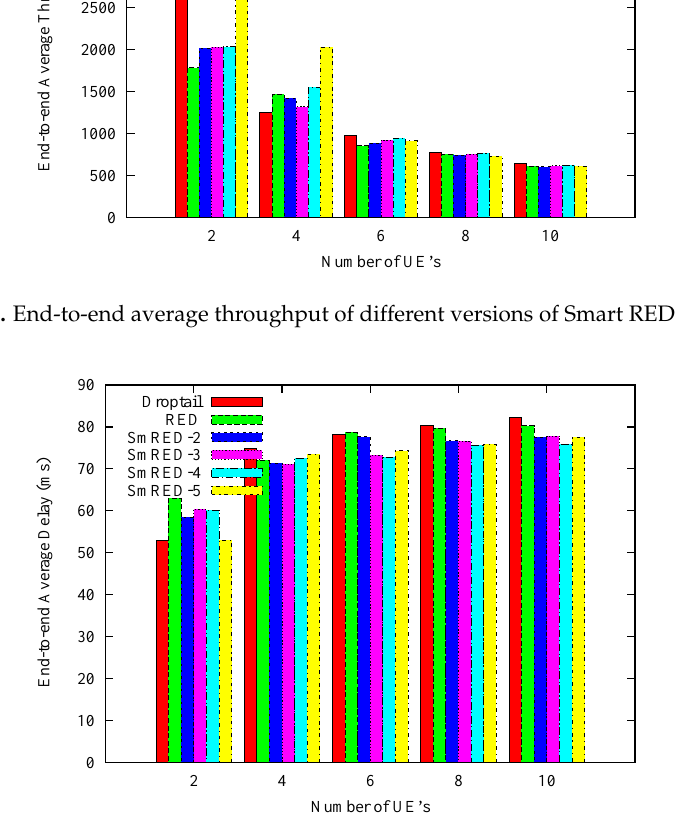
Figure 9. End-to-end average delay of different versions of